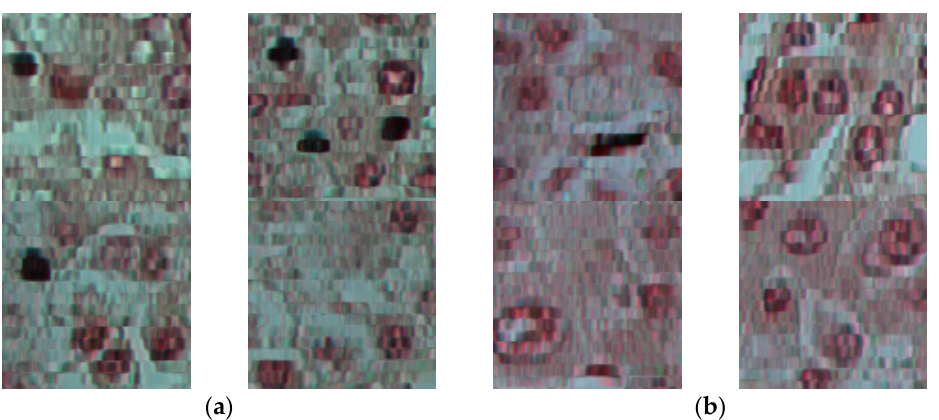
Figure 4. Sample patch images taken with 40X magnification, and the image size is 100 × 100 pixels. ( a ) Tumor sample patches; ( b ) Healthy sample